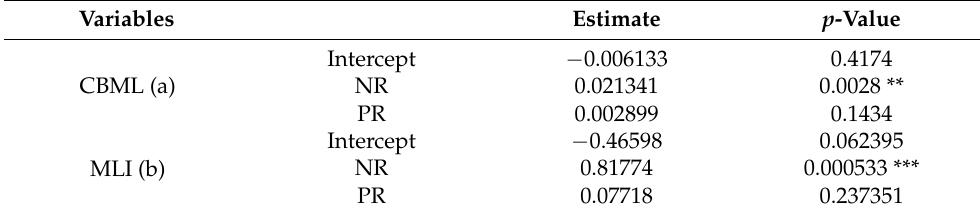
Table 2. Regression analysis results.